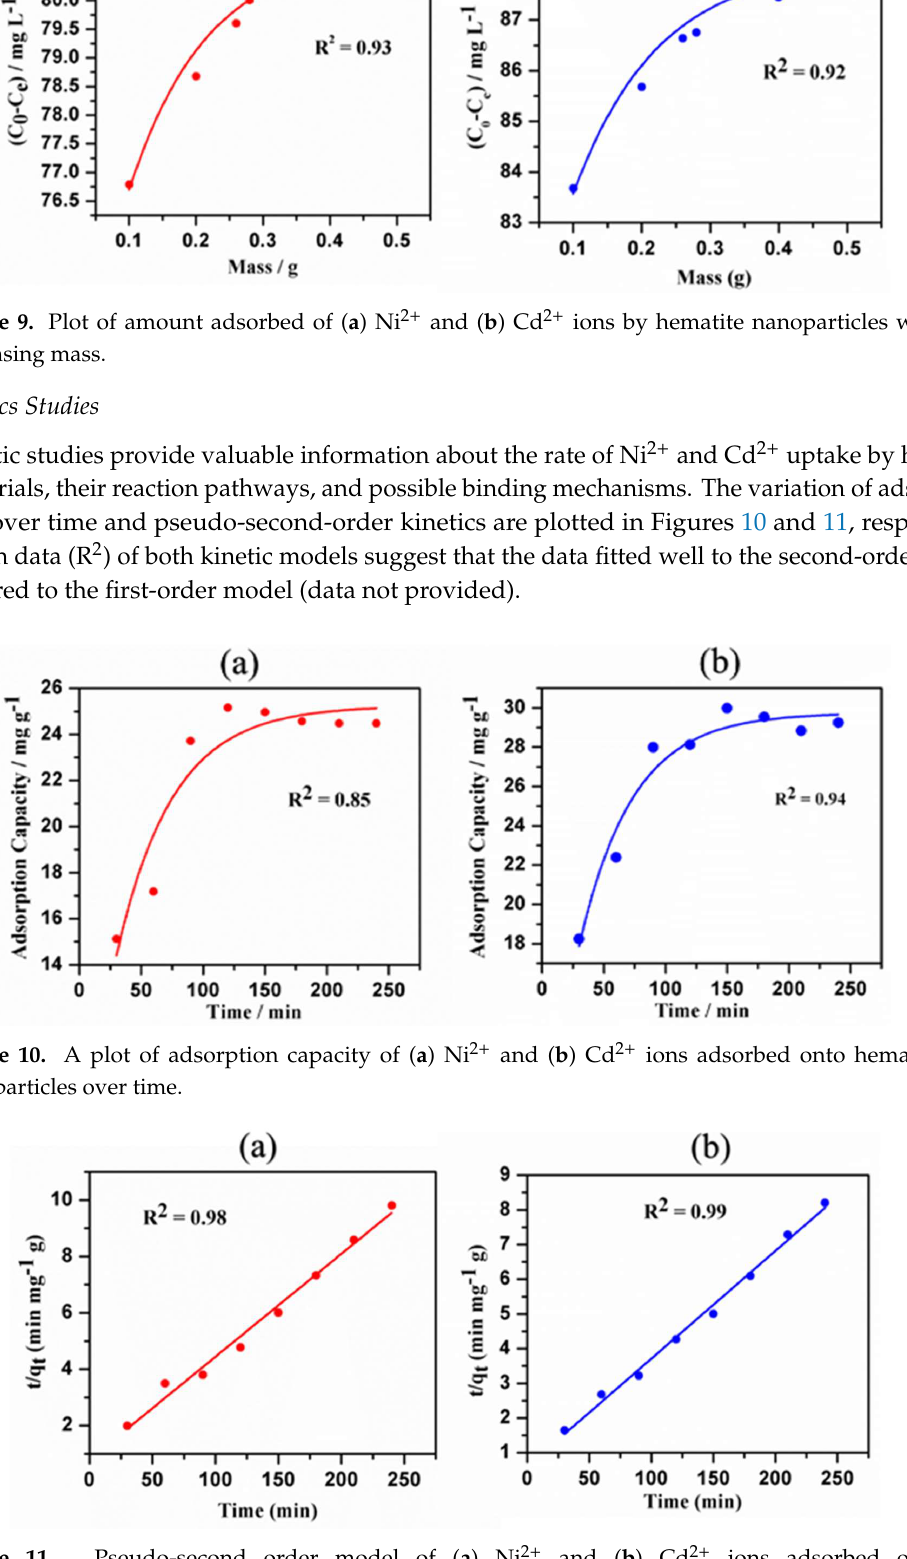
Figure 11. Pseudo-second order model of ( a ) Ni 2+ and ( b ) Cd 2+ ions adsorbed onto hematite nanoparticles.